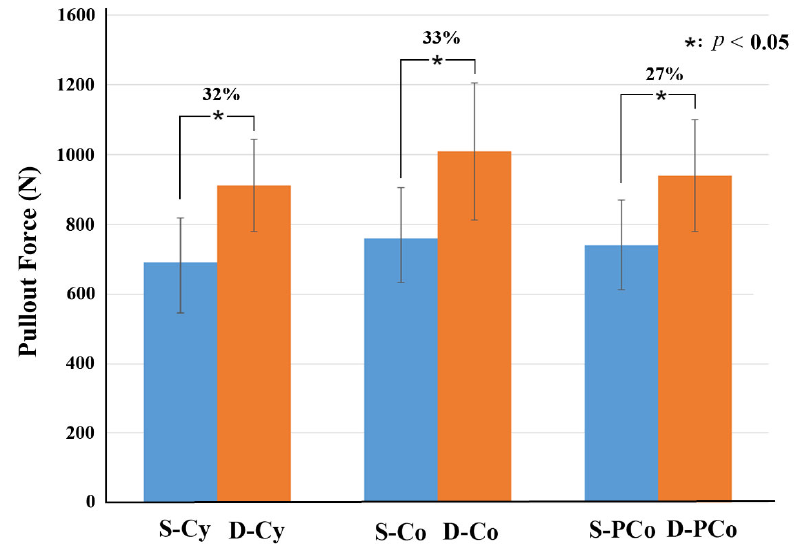
Figure 6. Mean maximal pullout force for screws of various geometries. For screws with the same shape, the ultimate pullout force was significantly higher in the dual-thread groups than in the single-thread groups. For the same thread profile, there was no significant difference between the different screw shapes. The increased percentage of pullout force from the single- to dual-thread groups was 32% in cylindrical screws, 33% in conical screws, and 27% in proximal ‐ conical screws. Groups with significant differences are indicated with the ‘‘*” symbol.